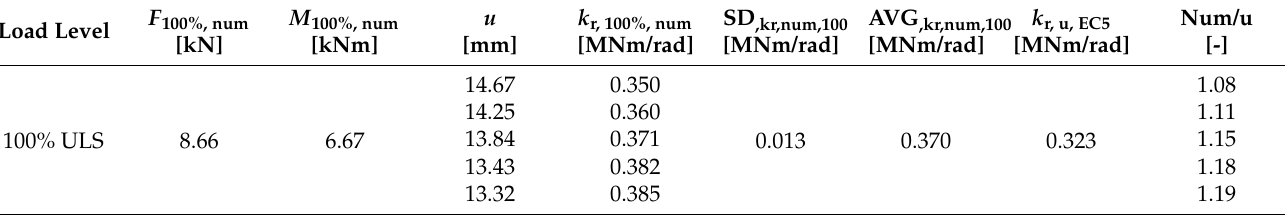
Table 14. Results of quasi ‐ static cyclic numerical modeling for Experiment A at 100% ULS.